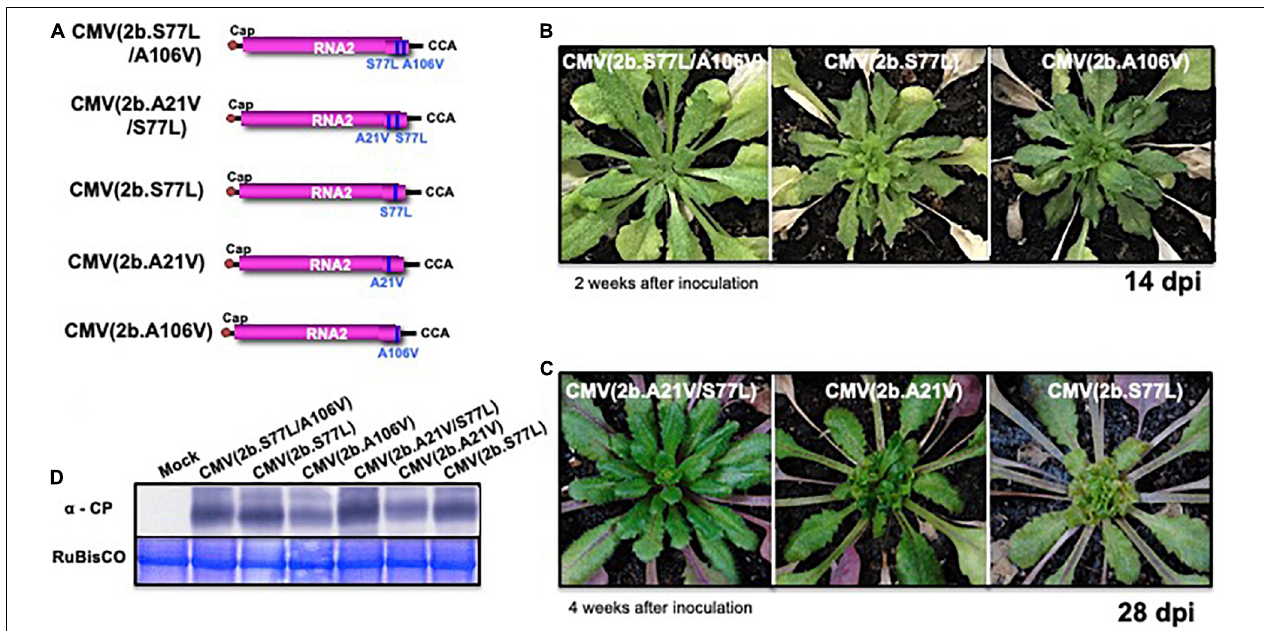
FIGURE 9 | The response of A. thaliana ecotype Col-0 to infection with CMV carrying single-nucleotide substitutions in the 2b gene of RNA2. The schematic structures of each CMV(Y) RNA2 encoding 2b protein with the single amino acid substitutions A21V, S77L, or A106V and their combinations (A21V/S77L or S77L/A106V), respectively, are shown in (A) . CMV(2b.S77L/A106V), CMV(2b.A21V/S77L), CMV(2b.S77L), CMV(2b.A21V), and CMV(2b.A106V) contain CMV(Y) RNA1 and RNA3 and those CMV(Y) RNA2 shown in (A) . The 5 (cid:48) -end of each RNA has a 7 mGpppG-cap structure (Cap), and the 3 (cid:48) -end of each RNA has the same nucleotide sequence (5 (cid:48) -CCA-3 (cid:48) ). Fully expanded leaves of Col-0 were inoculated with CMV(2b.S77L/A106V), CMV(2b.A21V/S77L), CMV(2b.S77L), CMV(2b.A21V), or CMV(2b.A106V). Photographs of young leaves of Col-0 infected at 14 and 28 dpi are shown in (B,C) . CMV coat protein in virus-infected leaves was detected immunologically by western blotting (D) . As an internal control, RuBisCO was detected by CBB staining and shown in the lower panel.